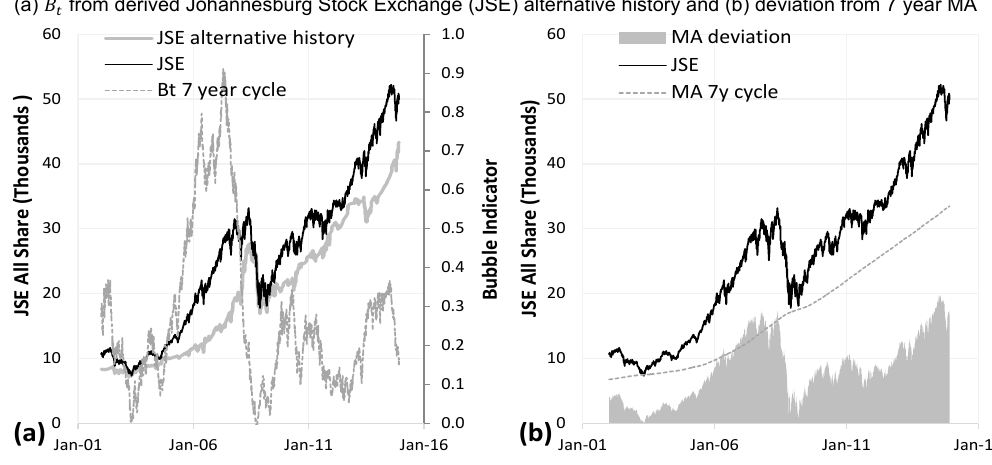
(a) 𝐵 L from derived Johannesburg Stock Exchange (JSE) alternative history and (b) deviation from 7 year